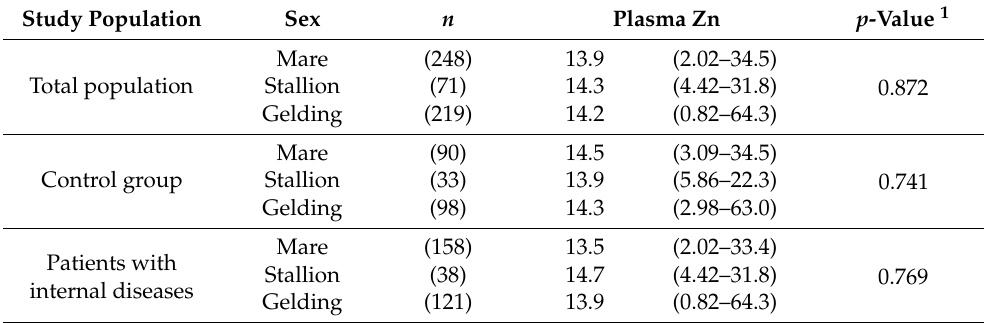
Table 3. Plasma Zn concentrations ( µ mol/L), depending on the sex of the hospitalized horses and ponies. Median (minimum–maximum).